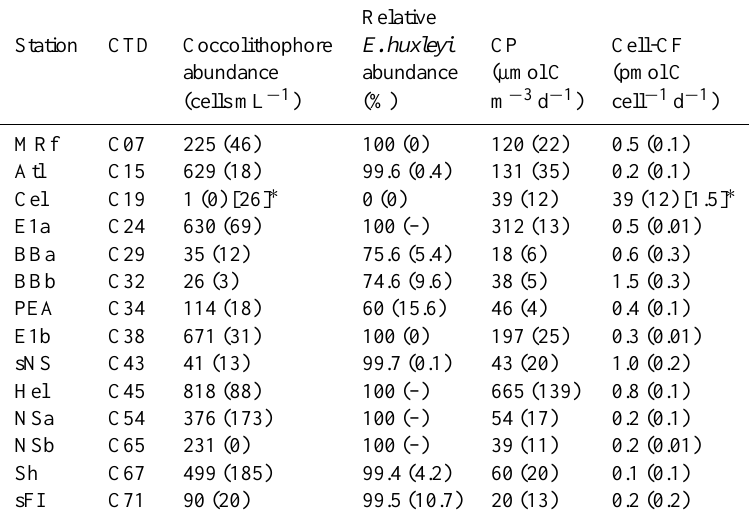
Table 3. Upper euphotic zone averages ( ± sd) of coccolithophore cellular abundances, E. huxleyi relative abundance, calcite production (CP), and cell-normalised calcification rate (cell-CF).